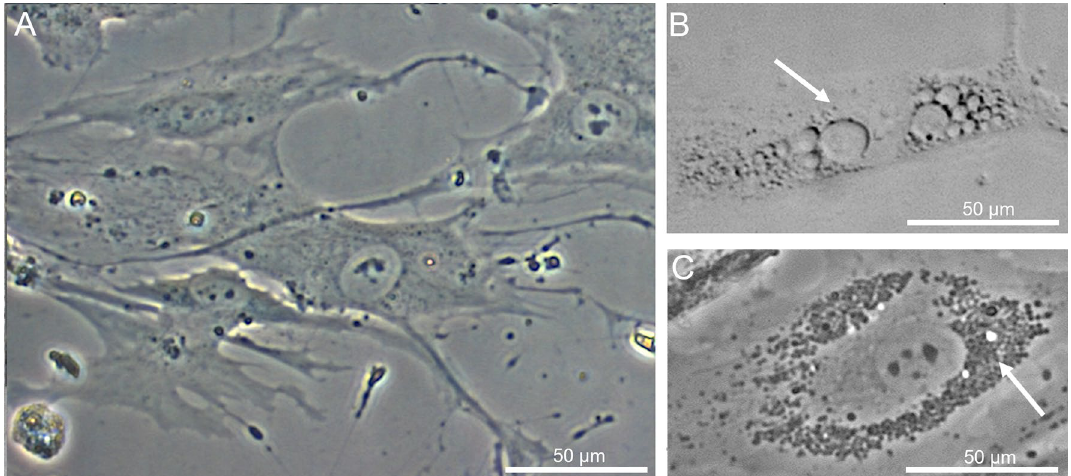
Figure 2. SBF affects the morphology of osteoblasts. phOBs (representative donor) under standard osteogenic culture conditions ( A ). phOBs after treatment with S. aureus SBF100 for 72 h ( B ) and S. epidermidis SBF100 after 72 h ( C ). Image A represent the characteristic appearance of osteoblasts in CO media. The cell membranes of treated phOBs ( B,C ) revealed different types of cell membrane damage, which could be induced by the different soluble factors of biofilm from S. aureus or S.